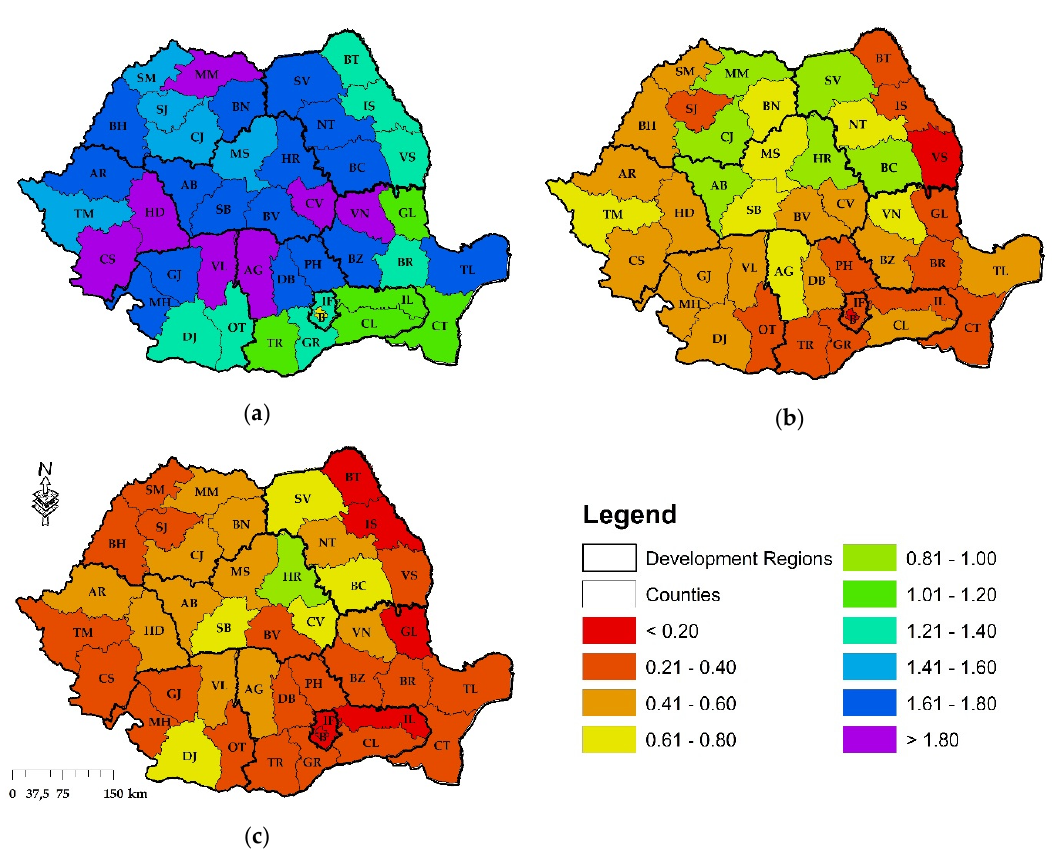
Figure 6. ( a ) The dilation fractal dimension (D dil3 ) of forested areas. ( b ) The dilation fractal dimension (D dil3 ) of deforested areas. ( c ) The dilation fractal dimension (D dil3 ) of reforested areas.